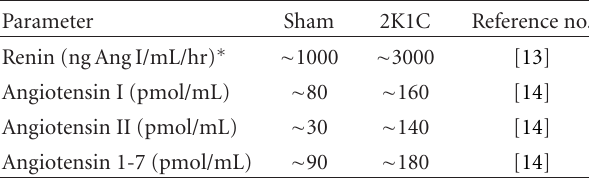
Table 2: Average values of plasma renin, angiotensin I, II and 1-7 in 2K1C mice compared to Sham mice, two weeks after clipping.